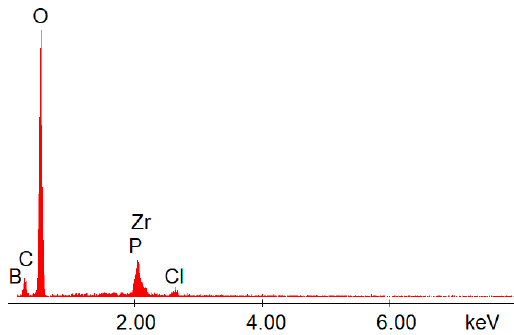
Figure 2. EDX data for the hybrid compound S1 .